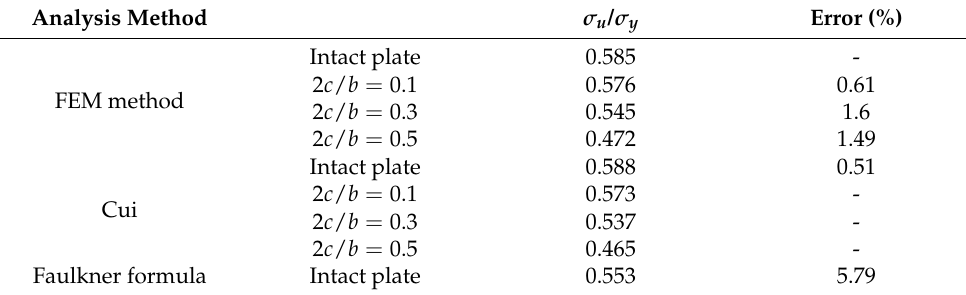
Table 4. Comparison of finite element method and formula.